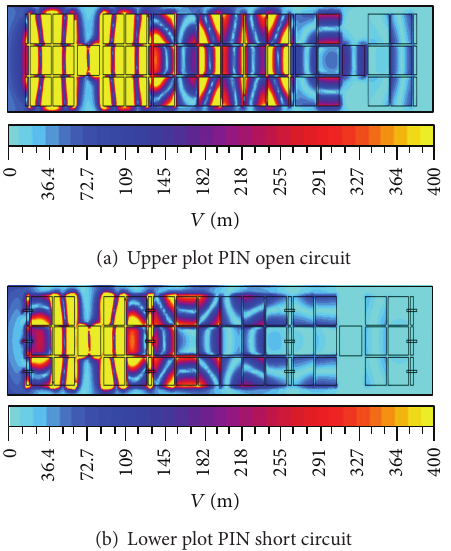
Figure 9: Surface currents on EBG coupled antenna system.